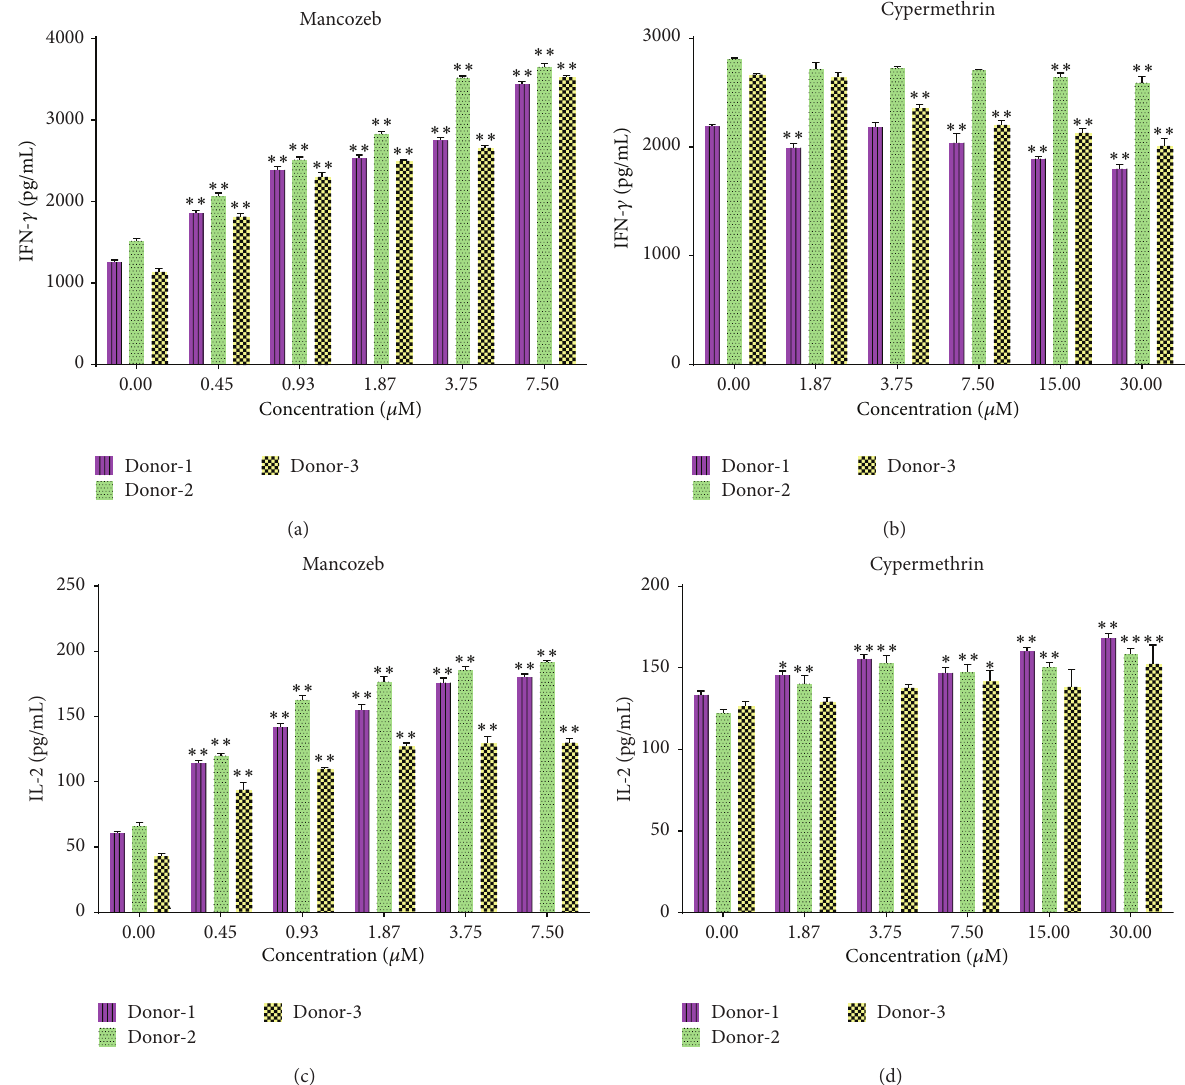
1 cytokine profiles. Effect on T 1 cytokines IFN 𝛾 and IL-2 production in PBMC cultures. (a) Mancozeb IFN 𝛾 . (b) Cypermethrin Figure 3: T H H IFN 𝛾 . (c) Mancozeb IL-2. (d) Cypermethrin IL-2. Values shown are mean ( ± SE) from triplicate samples conducted with PBMC from three volunteers. ∗ 𝑃 < 0.05 ; ∗∗ 𝑃 < 0.01 versus zero control. For each donor, statistical analyses performed across the doses showed that resultant IFN 𝛾 values were consistently significantly different as a function of dose in the mancozeb